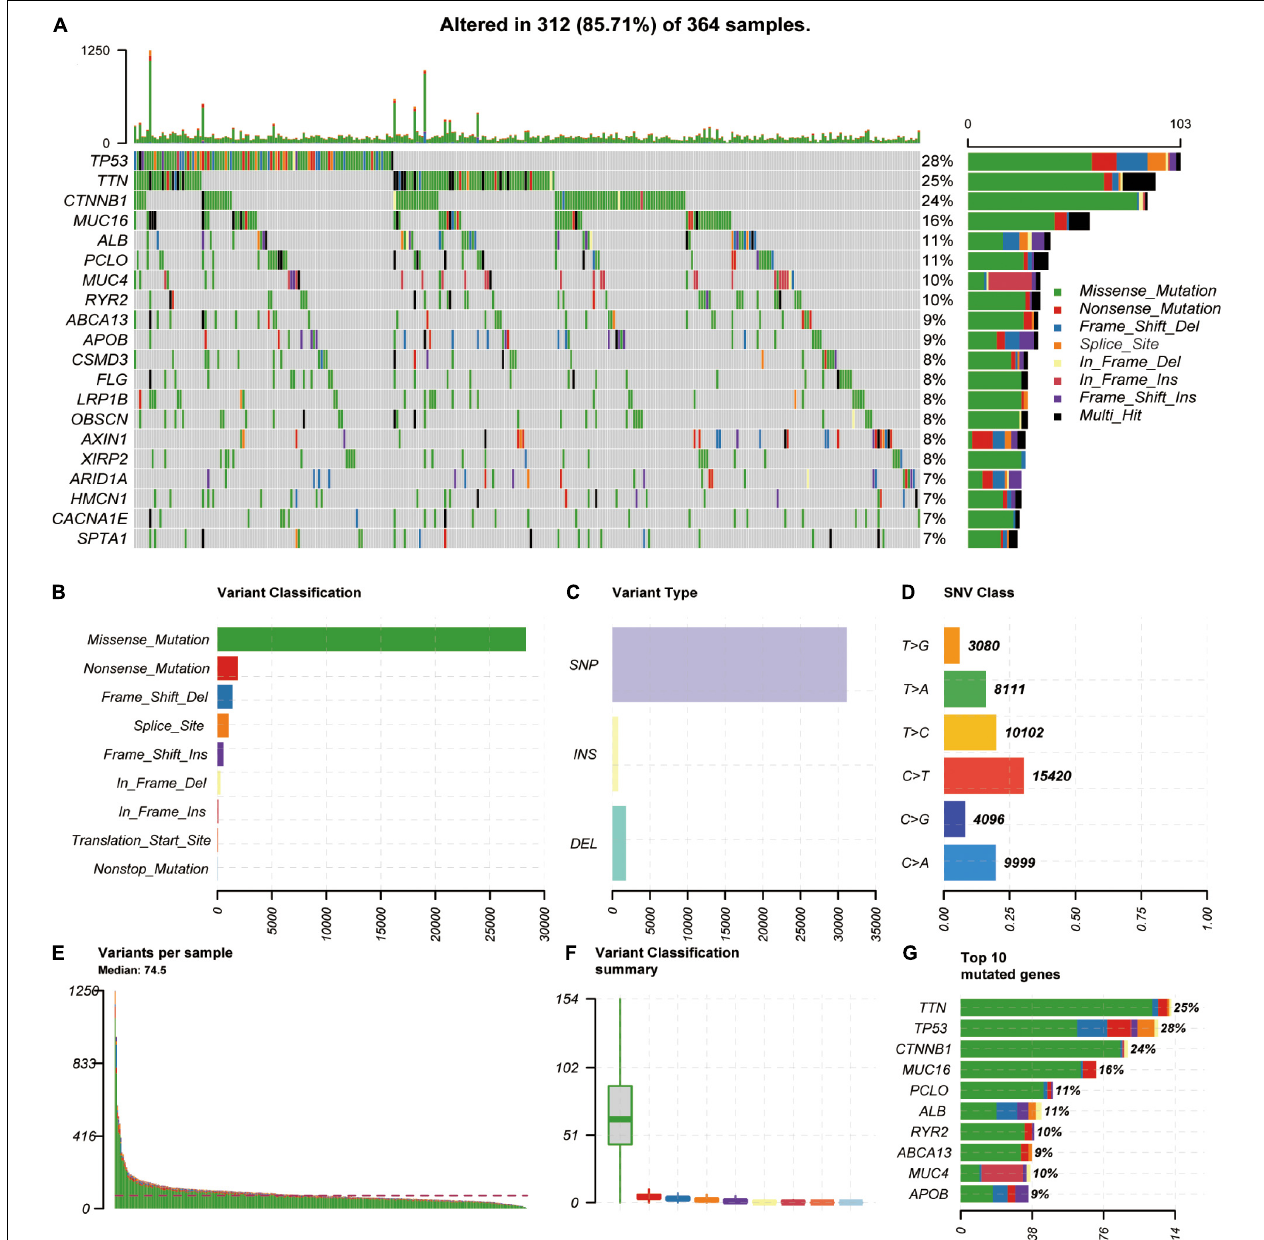
FIGURE 1 | Genome–wide mutation profiles in LIHC. (A) Landscape of mutation profiles in LIHC samples. Mutation information of each gene is shown in the waterfall plot, where different colors represent different types of variation. (B–D) Cohort summary plot displays distribution of variants according to variant classification, type, and SNV class. (E) Mutation load in each sample. (F) Variant classification in each sample. (G) Top 10 mutated genes in LIHC. LIHC, liver hepatocellular carcinoma; SNV, single-nucleotide variant.